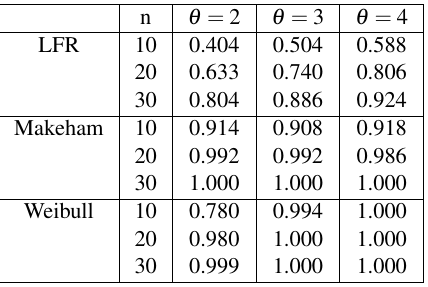
Table 3. Power estimates at λ = 0 .